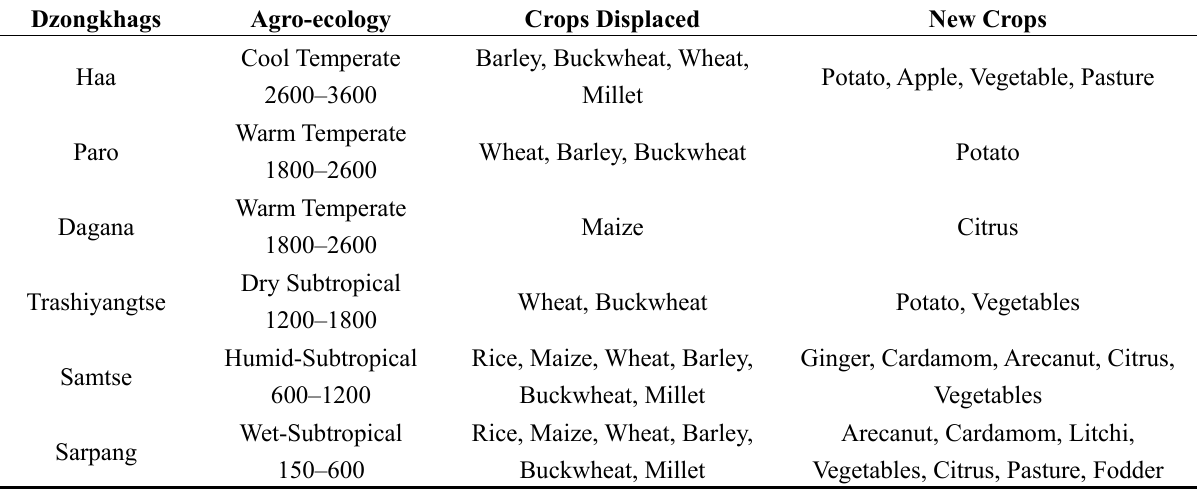
Figure 1. Frequency of different threats to cereals diversity reported by farmers. Table 5. Information on cereals displaced and crops displacing them in study